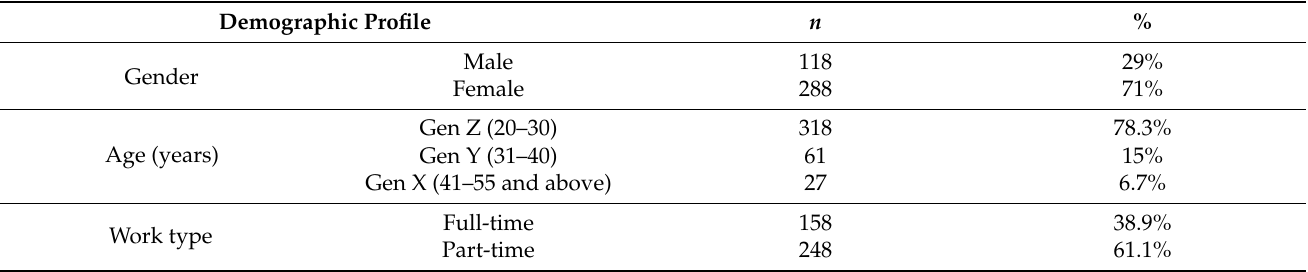
Table 2. Demographic